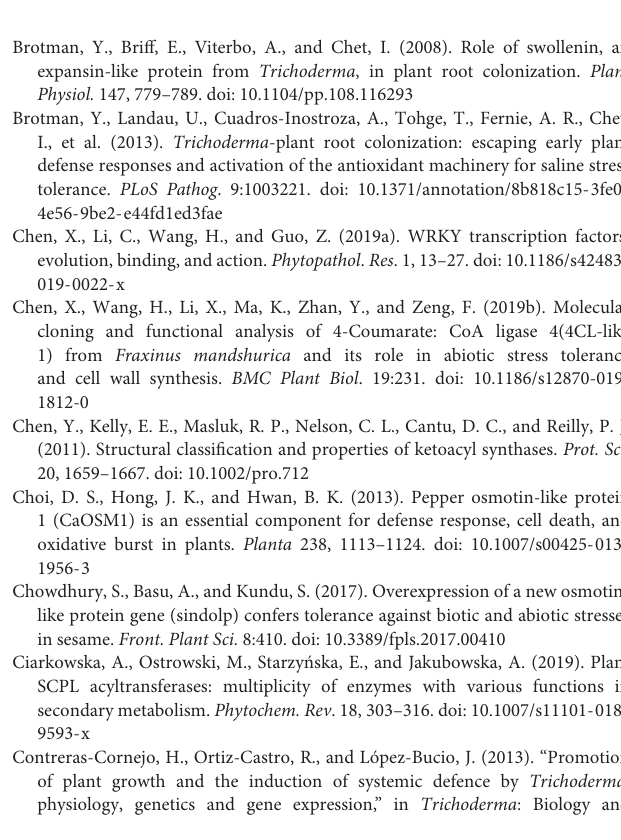
Supplementary Table 3 | List of differentially expressed upregulated